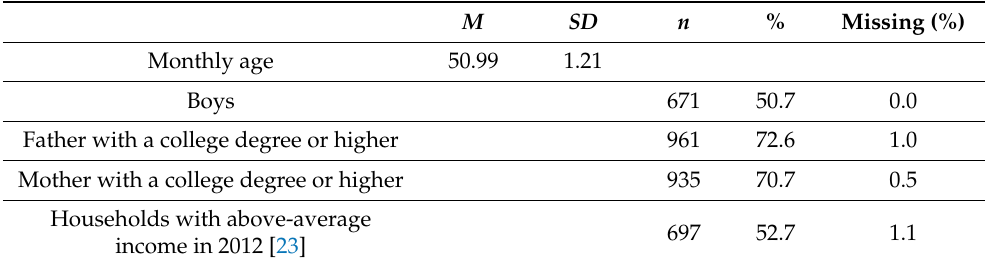
Table 1. Participant demographics by sample ( n =